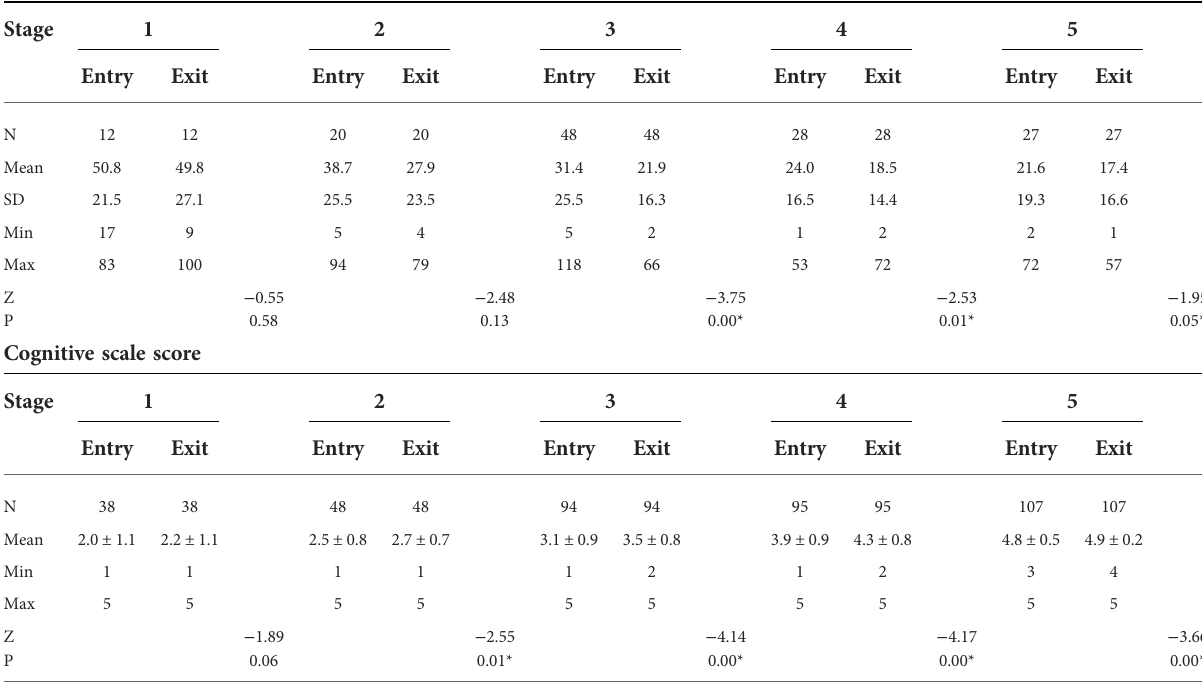
TABLE 4 PCSS and cognitive scale score at RTS stage entry and exit ( N =107).